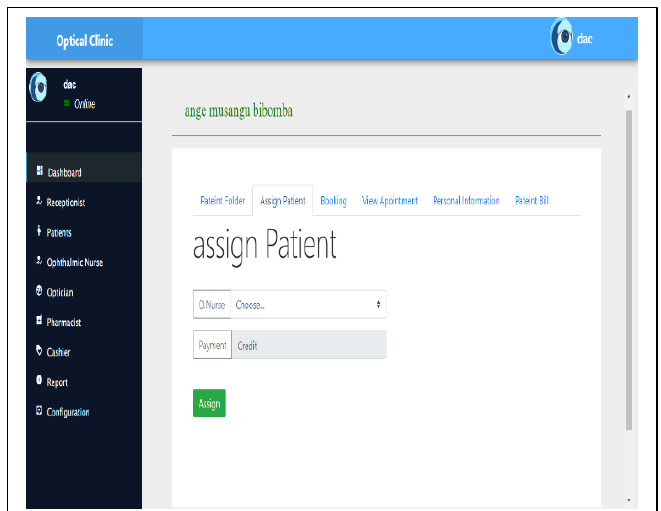
Figure 23. Assign New Patient Interface